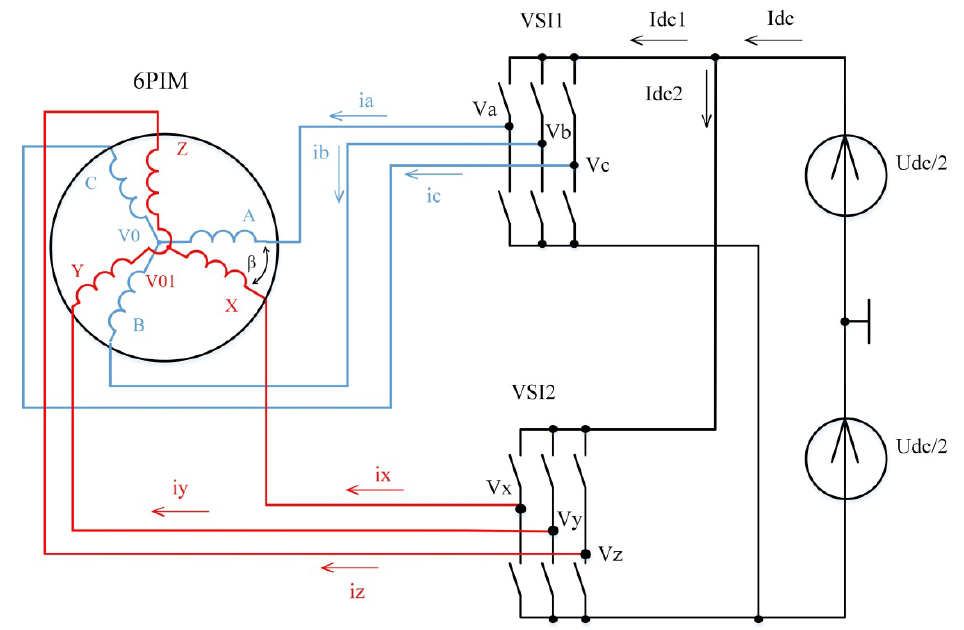
Figure 4. Block diagram of switch control-based dual-winding IM.